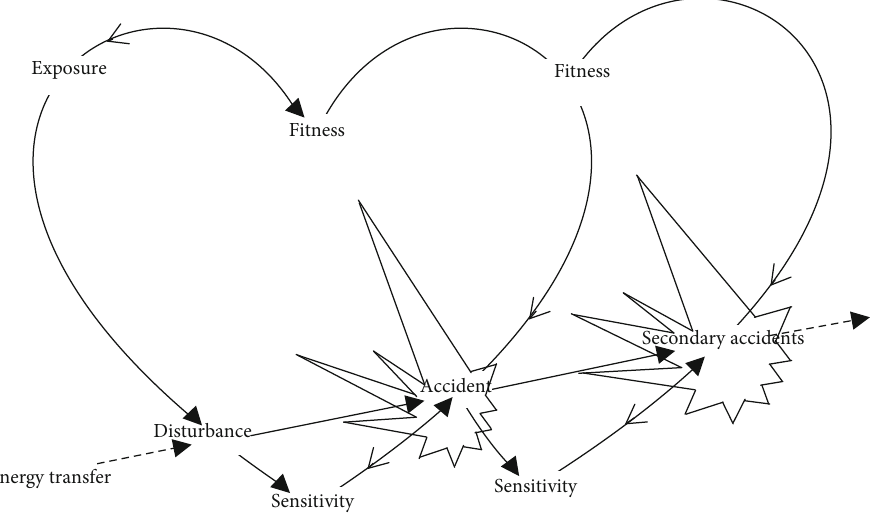
Figure 2: “ Glass heart ” vulnerability secondary accident